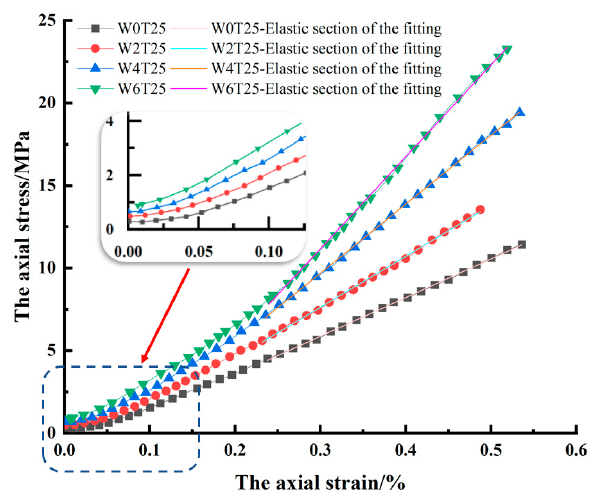
Figure 9. Stress–strain curve before yield point.